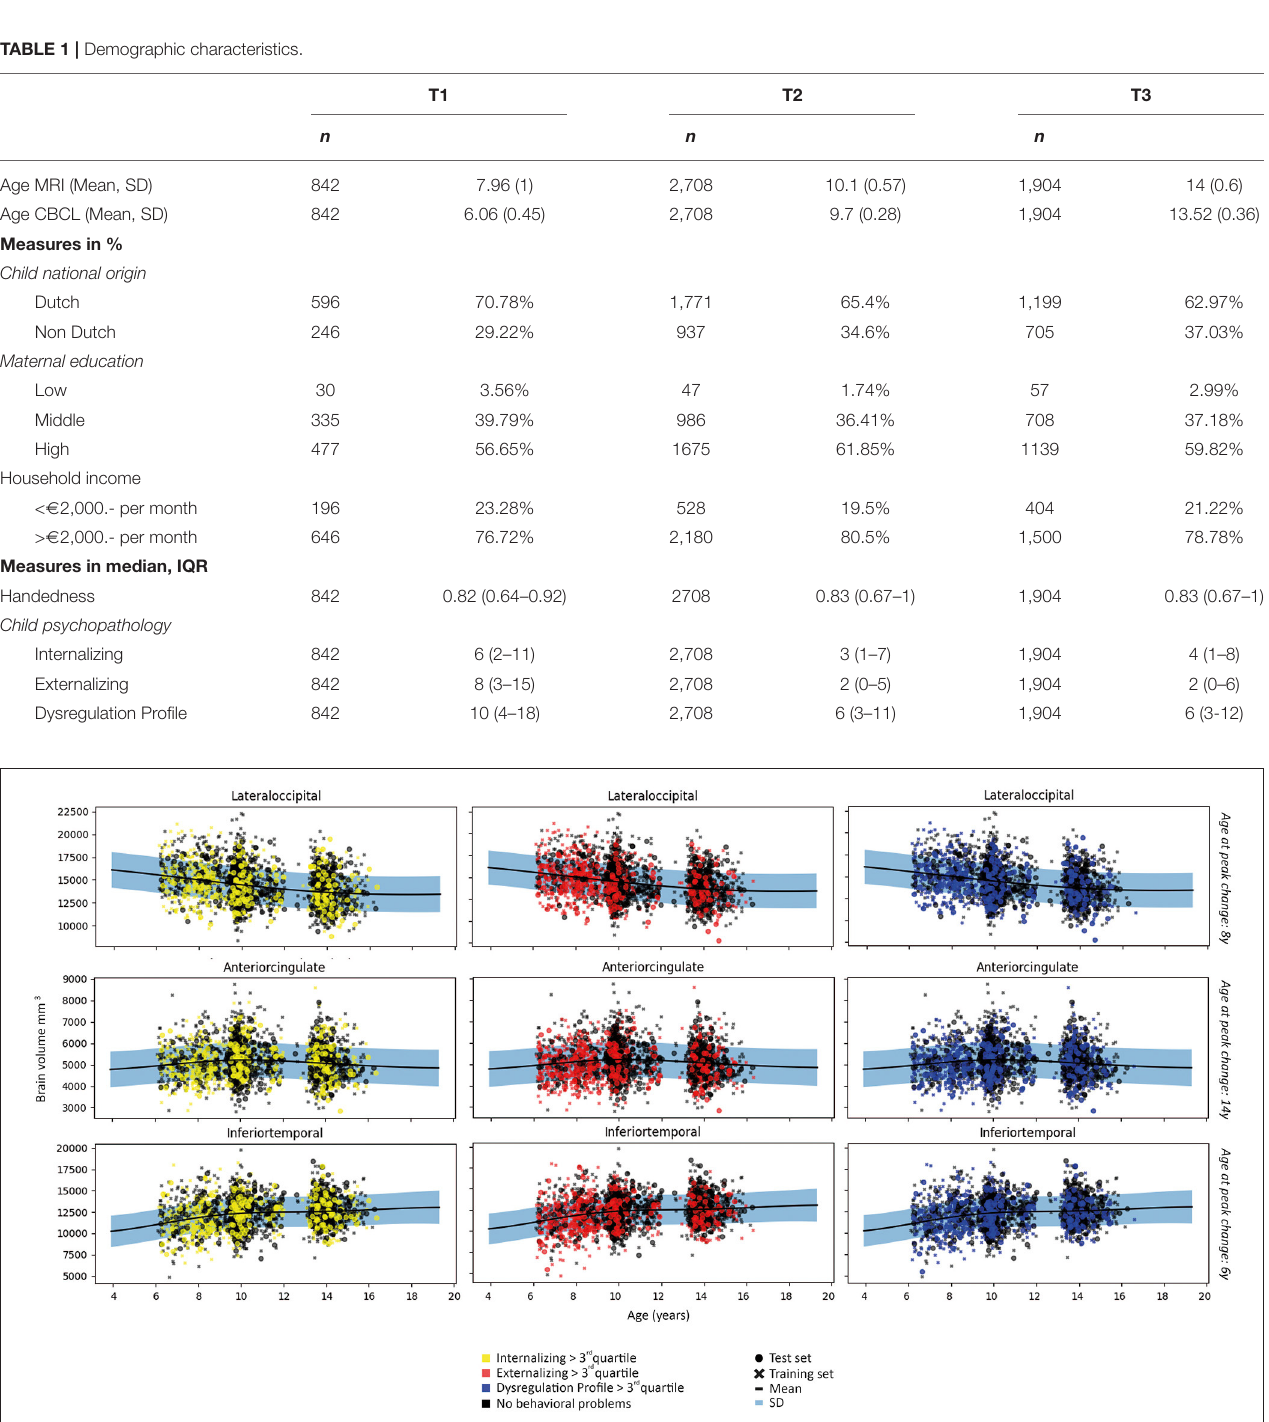
FIGURE 2 | Examples of patterns of (sub-)cortical volume for each subject in the first fold and the fit of the normative model to the (sub-)cortical volume in the training set. A wider prediction range outside of data distribution is used for visualization purposes. For illustrative purposes, measures are rescaled to the original means and standard